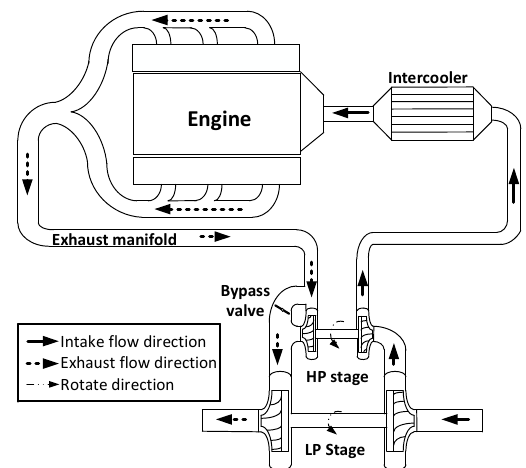
Figure 1. Schematic of regulated two-stage turbocharging system.